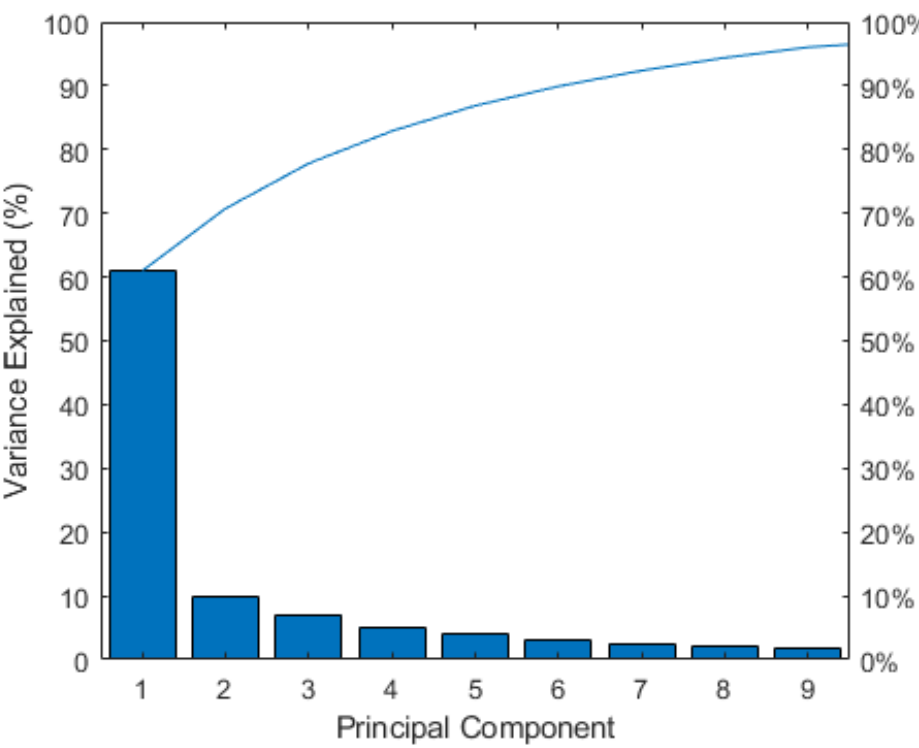
Figure 7. Variance of the first 10 principal components after variable reduction.